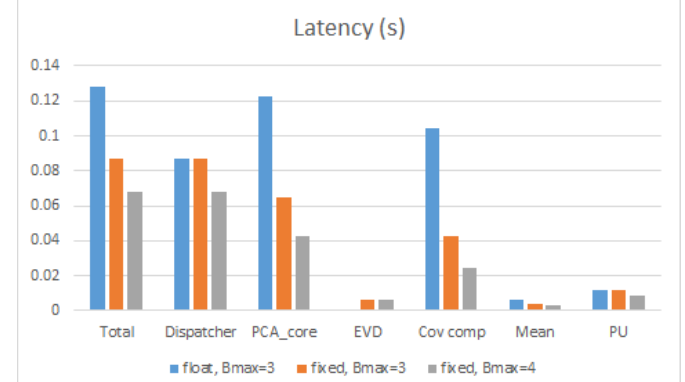
Figure 13. Comparison of the latency of the fixed- and floating-point design for Zedboard, B = 12, pixels = 300 ×